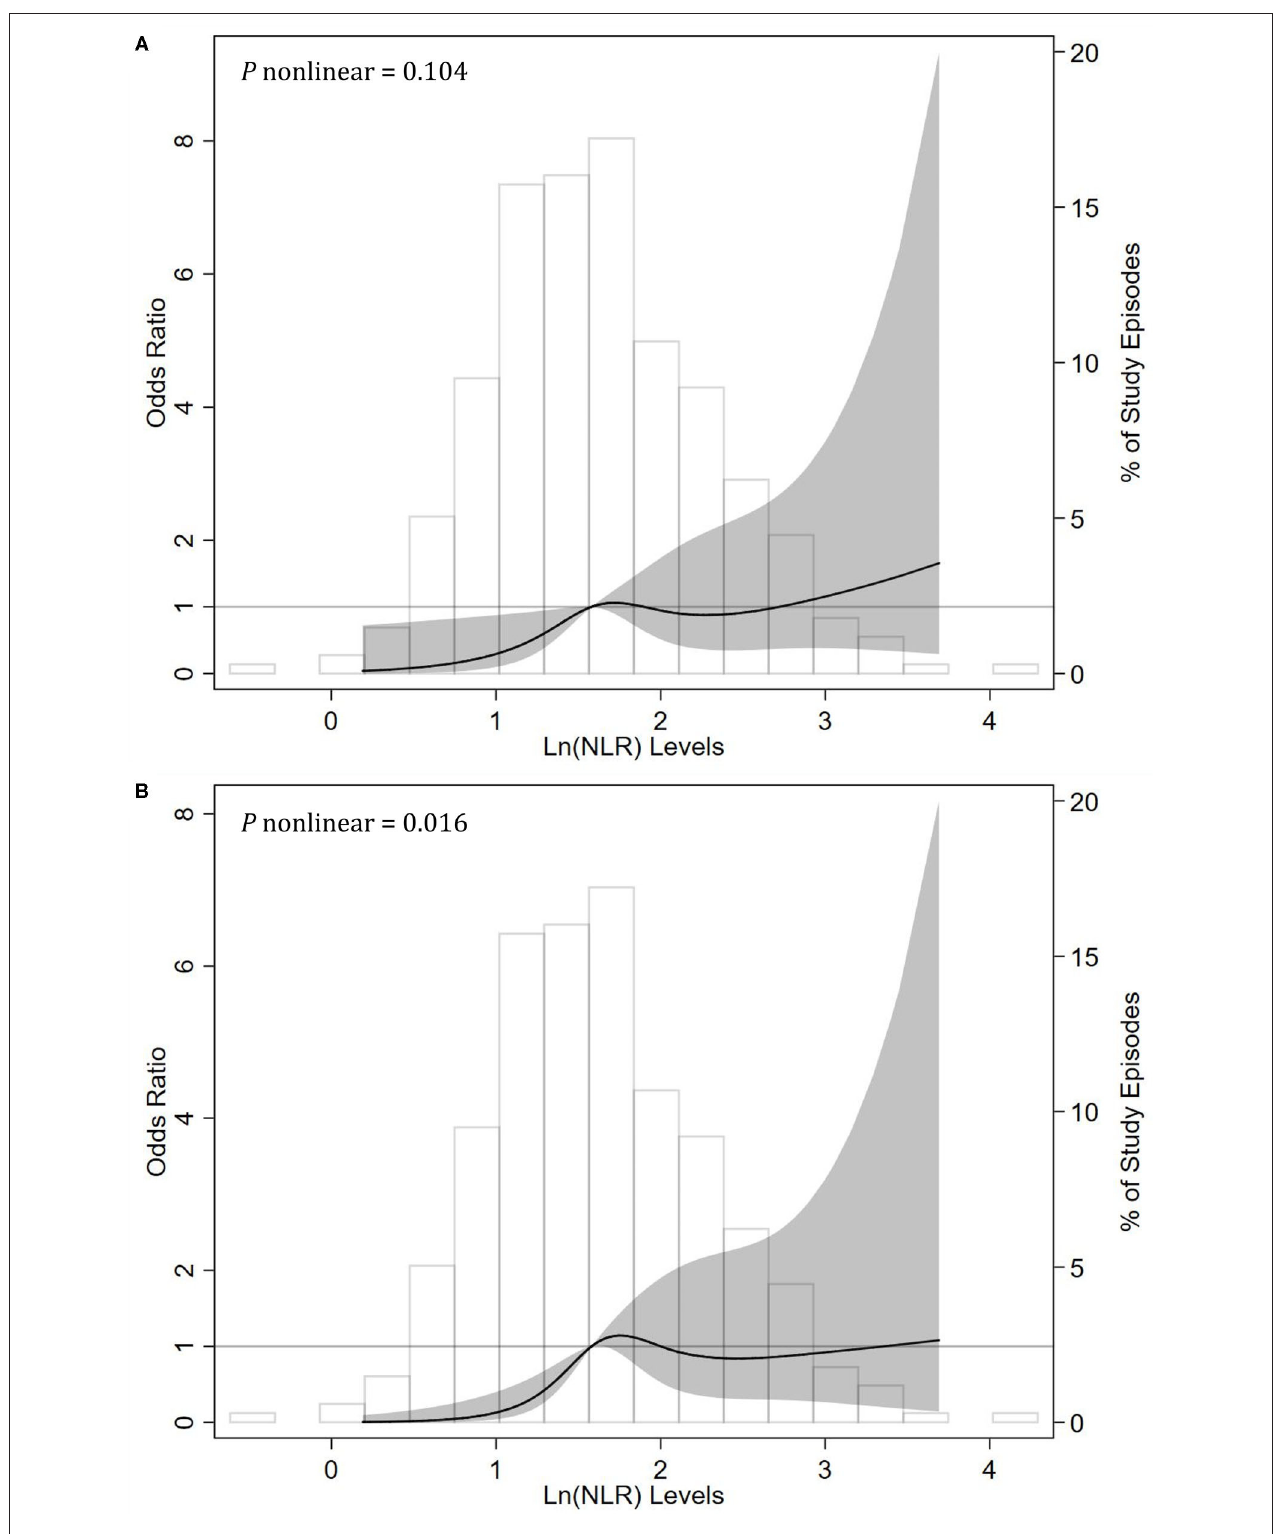
FIGURE 2 | Associations between neutrophil-to-lymphocyte ratio (NLR) levels and risks of (A) treatment failure and (B) catheter removal events among episodes with peritonitis using restricted cubic spline (RCS) methods. RCSs were done with knots at the 25th (1.18), 50th (1.58), 75th (2.06), and 95th (2.87) percentiles of